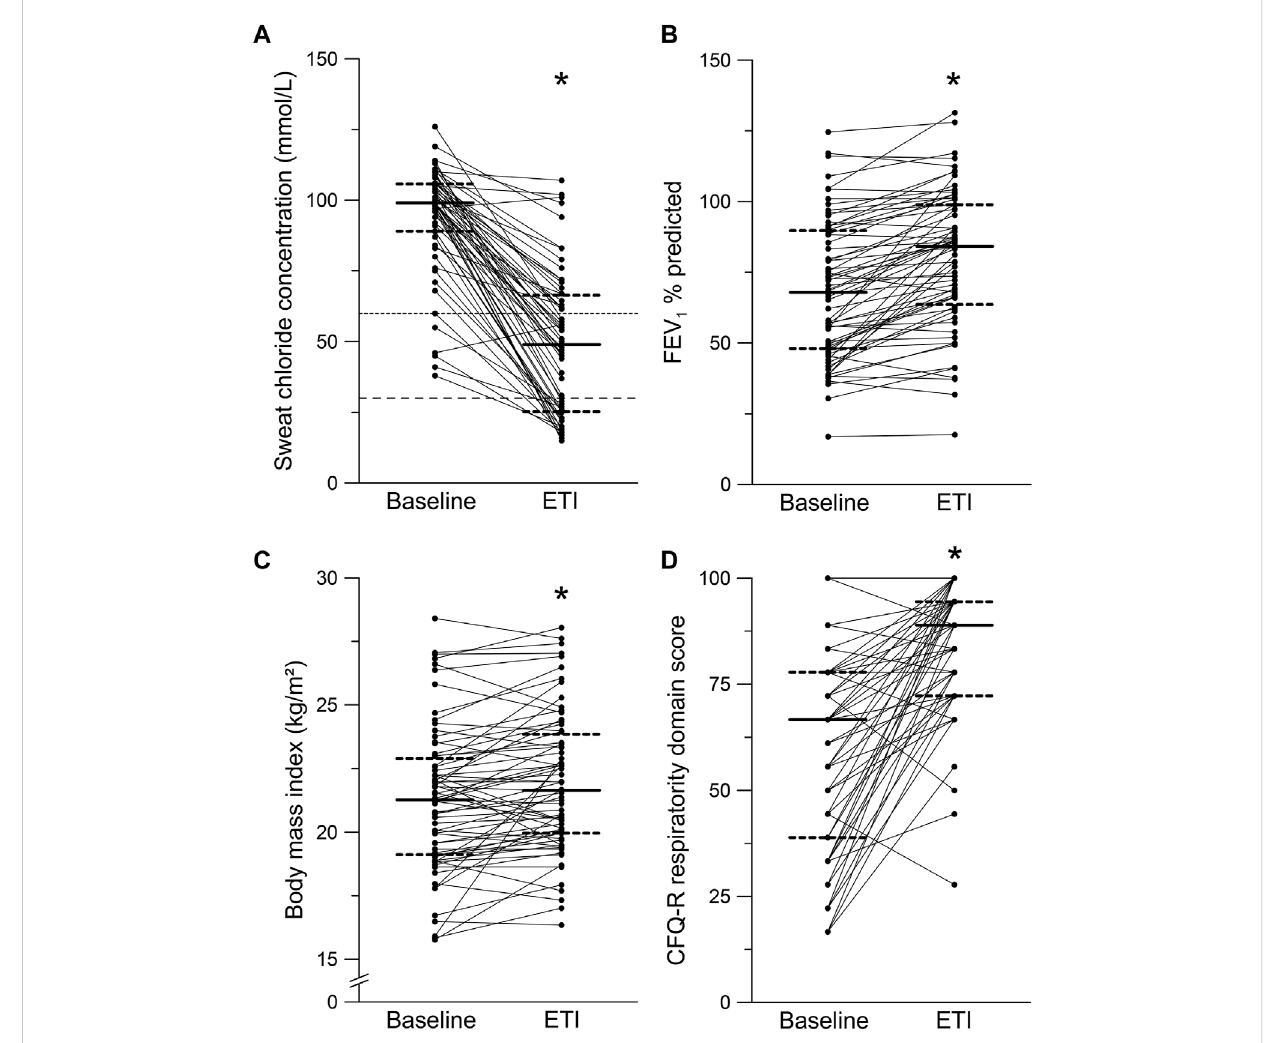
Effectsofelexacaftor/tezacaftor/ivacaftor (ETI)onsweatchlorideconcentration,percent predicted forcedexpiratory volumeinone second(FEV1% predicted), body mass index (BMI) and Cystic Fibrosis Questionnaire-Revised (CFQ-R) - respiratory domain. (A – D) Paired measurements of sweat chloride concentration (A) , FEV1% predicted (B) , BMI (C) and CFQ-R respiratory domain score in patients with CF and at least one F508del mutation at baseline and after initiation of ETI therapy. Solid lines represent the group median and dashed lines represent 25th and 75th percentile. * p < 0.001 compared with